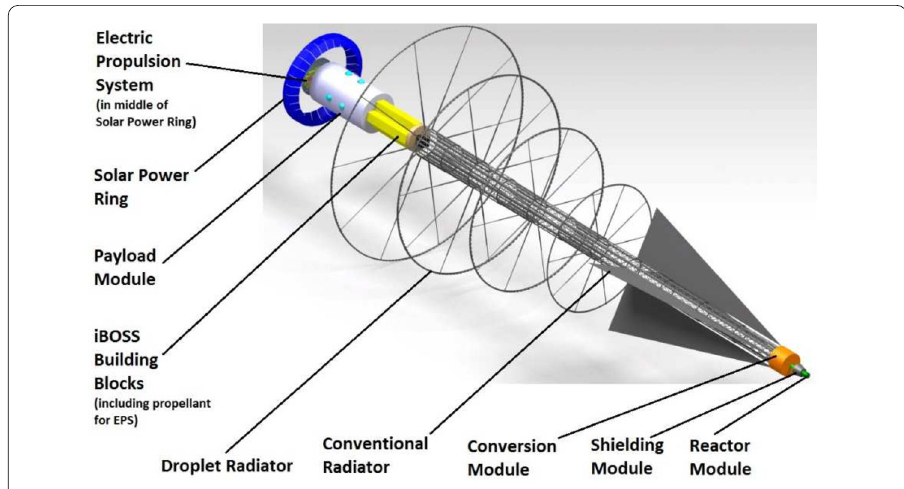
Figure 1 2021: concurrent engineering designed INPPS flagship with indications of all nuclear and non-nuclear subsystems. The focus in the paper is on the EPS, with its CET plate completely opposite to the reactor module and behind the solar power ring